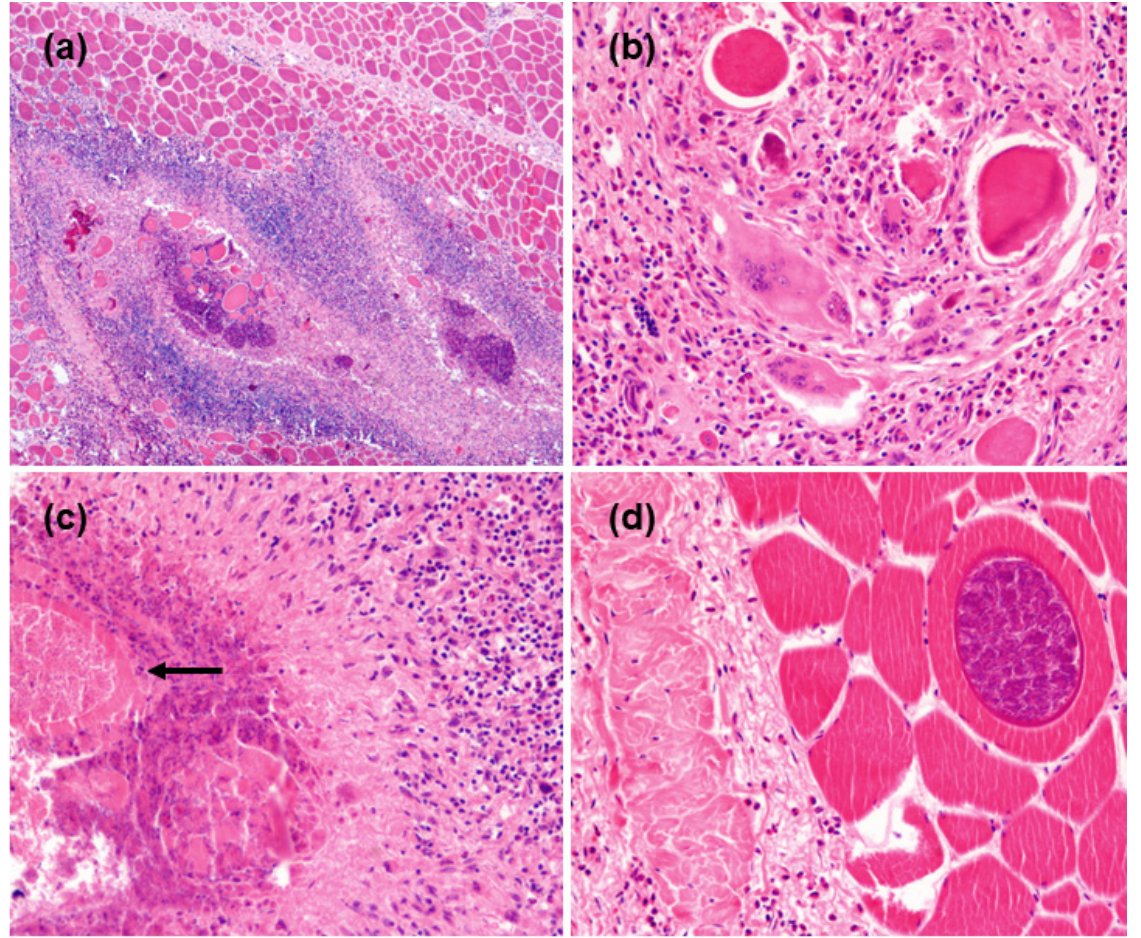
Figure 2. Histological appearance of the infected skeletal muscle. ( a ) A vast lesion showing mineralized foci of necrotic tissue surrounded by inflammation, mostly mononuclear elements. H.&E. 4 × ( b ) Higher magnification shows a few necrotic fibers in the center of inflammatory tissue composed by palisades epithelioid macrophages, multinucleated giant cells, admixed with eosinophils and lymphoid tissue. H.& ‐ E. 20 × ( c ) On the left, extensive necrotic material in which the debris of a protozoan cyst are visible (arrow). Around them a layer of necrotic inflammatory cells surrounded by granulomatous tissue. H.&E. 10 × ( d ) Top right: A cyst in the middle of a viable skeletal muscle fiber, with no inflammation. Left: Thick connective tissue (fibrosis) with scattered eosinophils . H.&E.10 × . 3.3. Serological and Molecular Results The meat juice IFAT resulted negative for T. gondii specific IgG at a 1:4 dilution. Concerning the molecular analyses, all of the PCR assays successfully amplified all of the three matrices examined. In detail, in the PCR targeting the Apicomplexa 18S rDNA, all nine specimens were positive, with a band of ~ 300 bp. Sequences were obtained from six samples (4 ML, 1 HM, 1 MJ) and a BLAST search gave 99.6% identity with S. hominis in five (3 ML, 1 HM, 1 MJ), and 99.6–99.3% Hammondia hammondi / T. gondii only from ML. The same samples tested with the multiplex PCR specific for cattle Sarcocystis showed a band of 420 bp of S. hominis . To confirm the results, the COI mtDNA of two samples (1 ML, 1 MJ) were sequenced. A BLAST search gave a 99.5% (ML) and a 99.7% (MJ) identity with S. hominis .